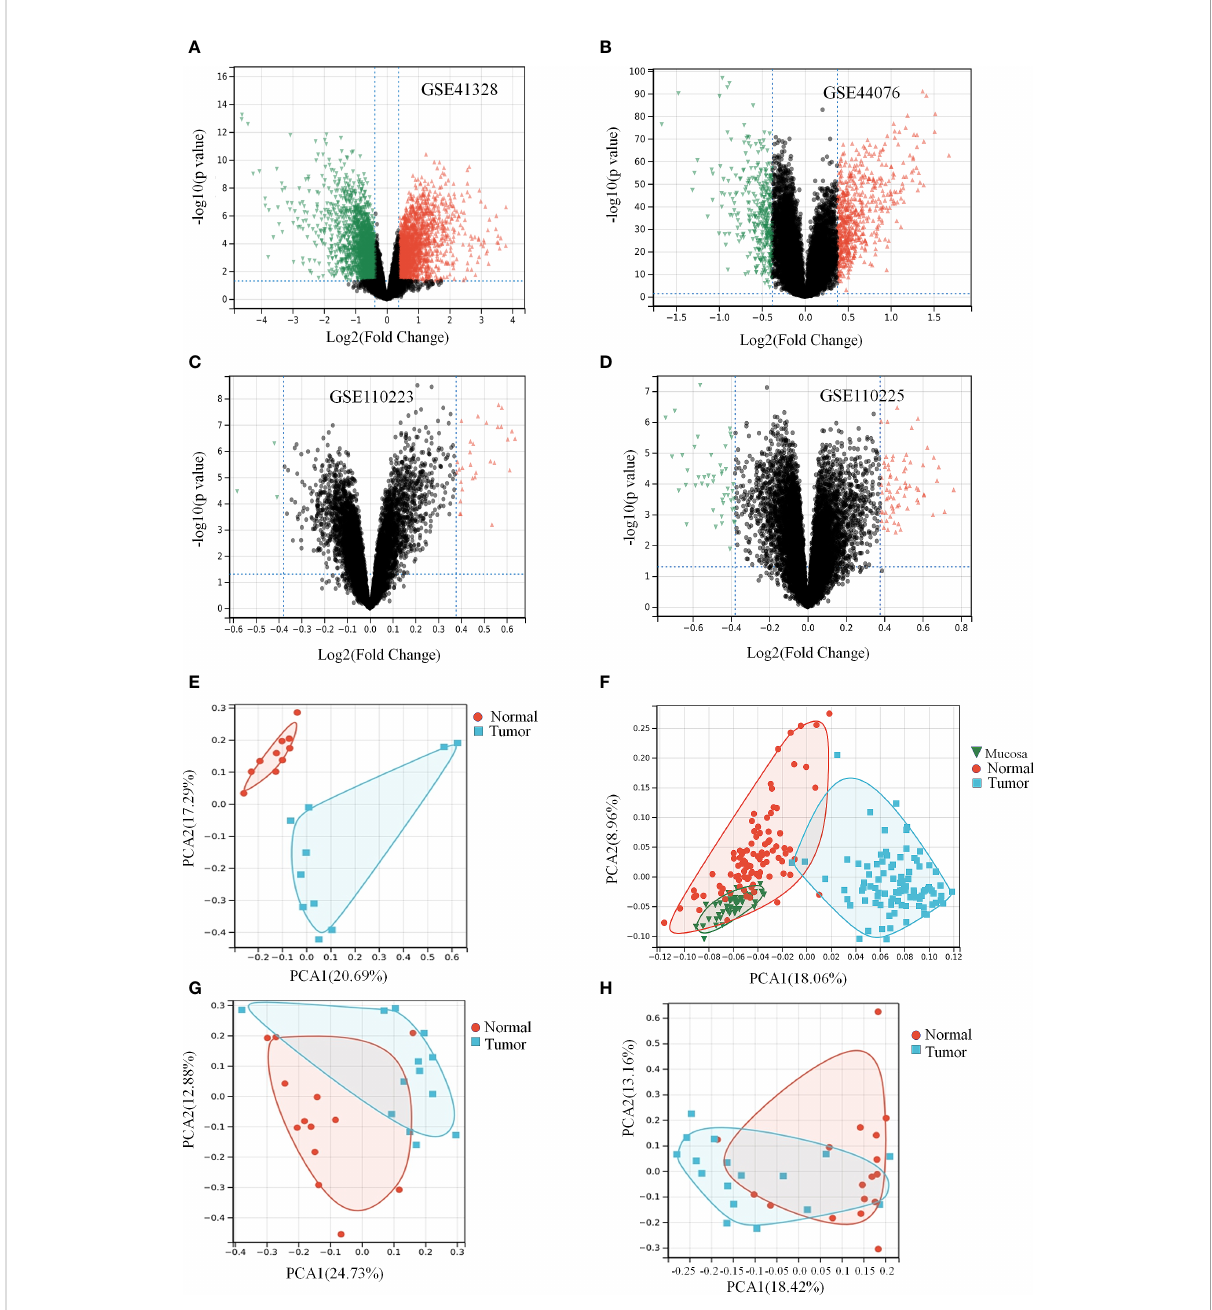
FIGURE 2 Colon cancer differentially causes the expression of genes in a certain extent. (Table 1) Expression differences of genes in data set . (A, E) Differential gene volcano plot and PCA analysis plot of GSE41328 dataset. (B, F) Differential gene volcano plot and PCA analysis plot of GSE44076 dataset. (C, G) Differential gene volcano plot and PCA analysis plot of GSE110223 dataset. (D, H) Differential gene volcano plot and PCA analysis plot of GSE110225